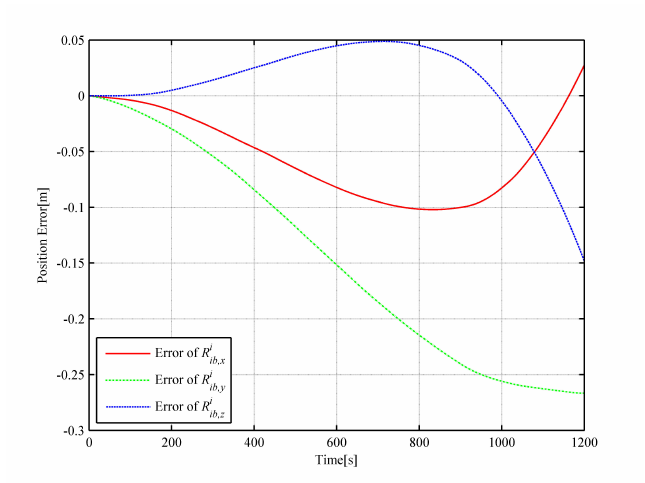
Figure 6. Curve of the position error (based on the inverse